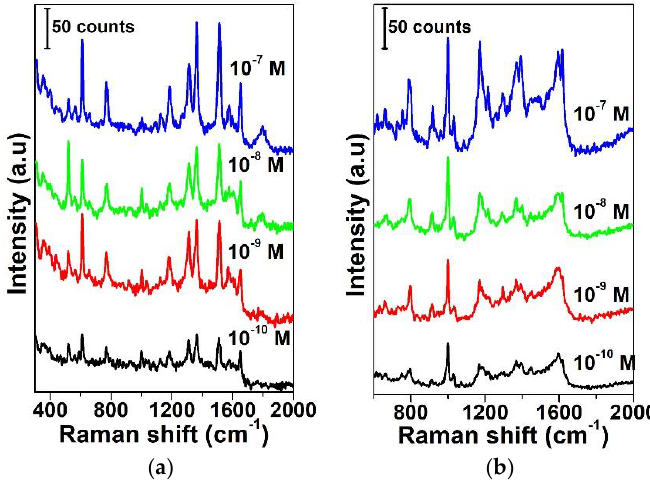
Figure 3. ( a ) Raman spectra of R6G with different concentrations (10 −7 , 10 −8 , 10 −9 , and10 −10 M) adsorbed on the surface of the SERS substrate. The integration time was 10 s. ( b ) Raman spectra of RB with different concentrations (10 −7 , 10 −8 , 10 −9 , and 10 −10 M) used to examine the reliability of the SERS substrate.